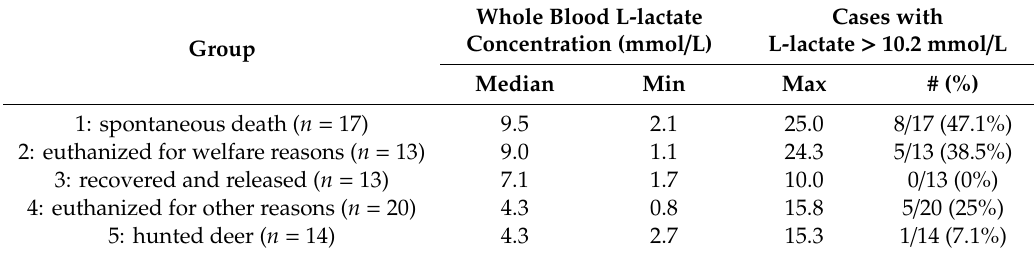
Table 1. Results of descriptive statistics on blood L-lactate concentrations among di ff erent groups